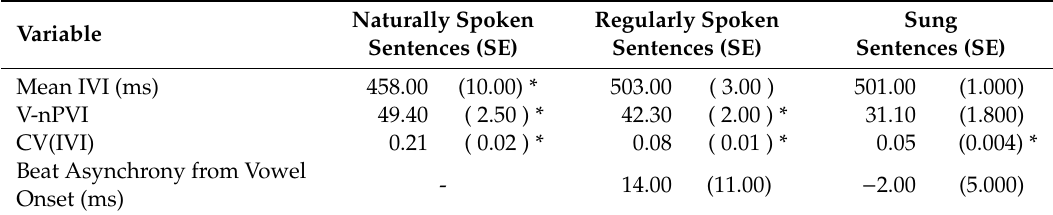
Table 4. Stimuli characteristics related to